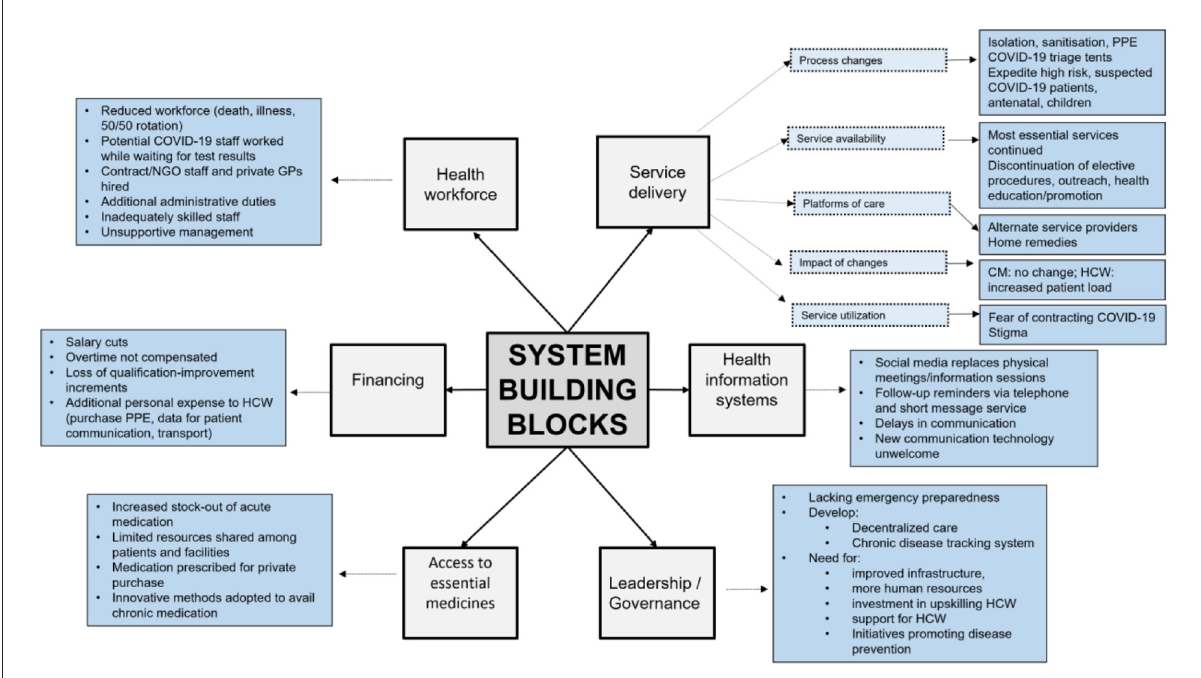
FIGURE2 Summary of the thematic